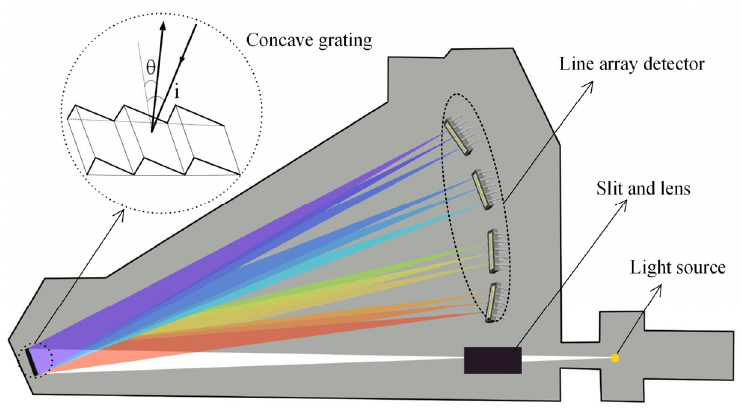
Figure 1. Traditional Paschen–Runge structure direct-reading spectrometer schematic.